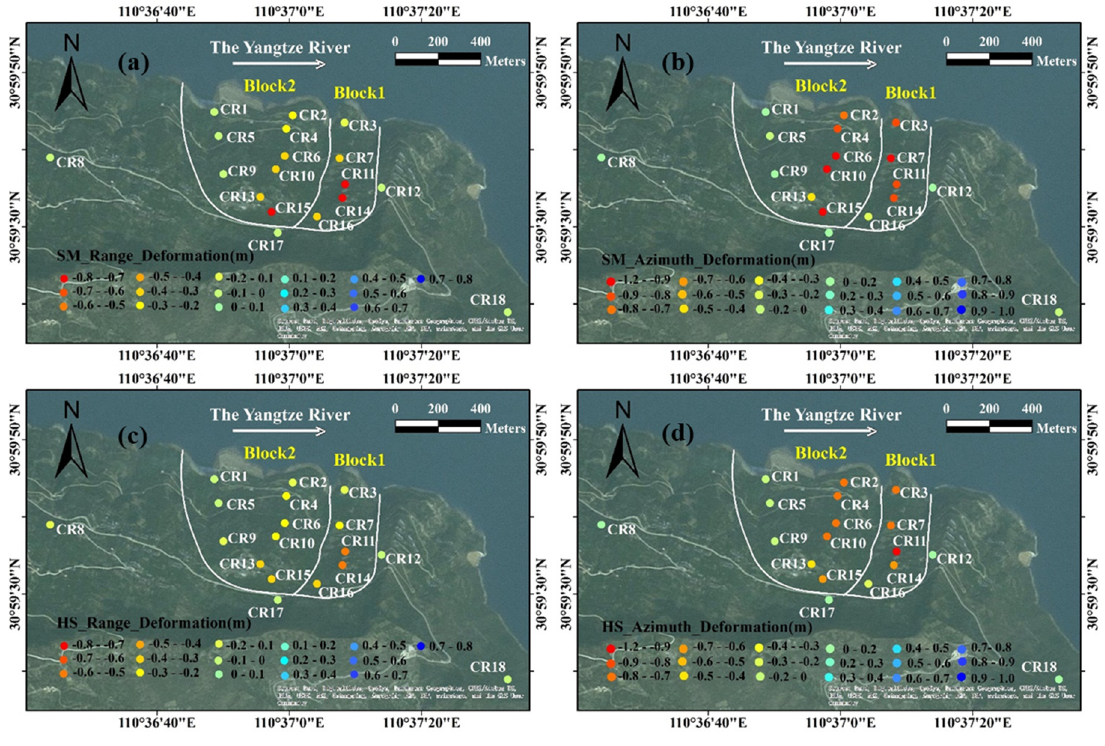
Figure 7. Monitoring displacements from 21 July 2008 to 1 May 2010 using SM data in ( a ) range and ( b ) azimuth; Monitoring Displacements from 21 February 2009 to 15 April 2010 using HS data in ( c ) range and ( d ) azimuth.